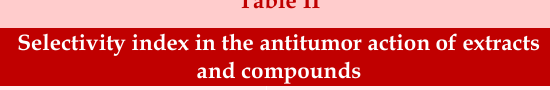
Selectivity index in the antitumor action of extracts and